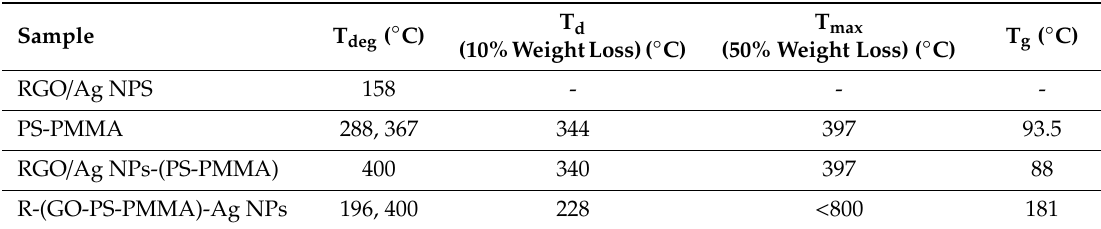
Table 1. Summary of the thermal properties based on TGA and DSC